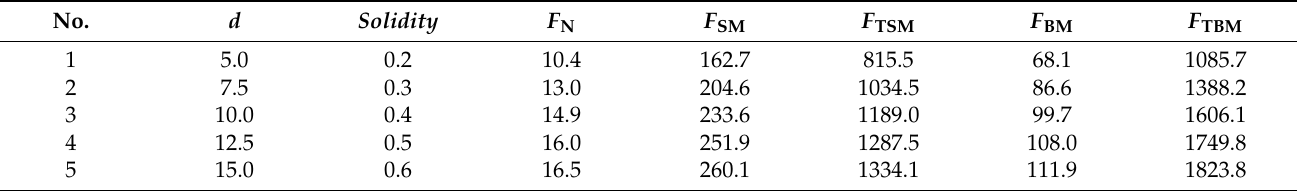
Table 4. Maximum tension on trash-blocking net and mooring system for different net